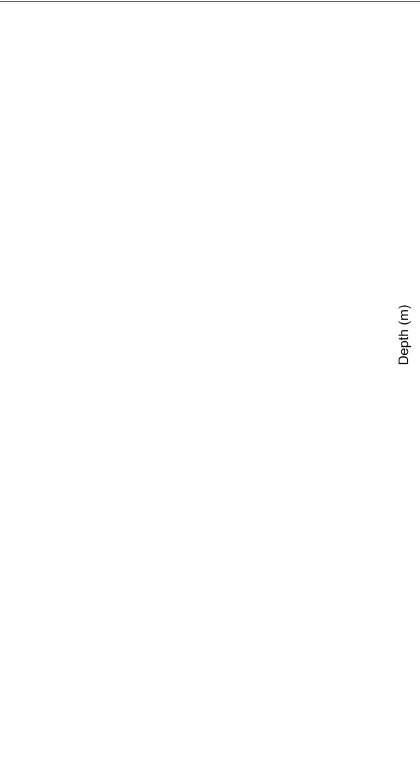
FIGURE 3 | Vertical distribution of temperature (upper axis, closed circles, °C) and nitrate (NO − 3 ) concentrations (lower axis, open squares, m mol L -1 ) in the Equatorial undercurrent upwelling (EUC) region and eastern region of the Gala ́ pagos Archipelago. The y-axis represents the depth (m). The dotted and solid lines indicate depths of the mixed layer and subthermocline layer, respectively. Of the 23 sites surveyed, the sites where data were measured at multiple depths (50%, 30%, 10%, and 1% incident irradiance) are displayed. Full data are available in Supplementary Table 1